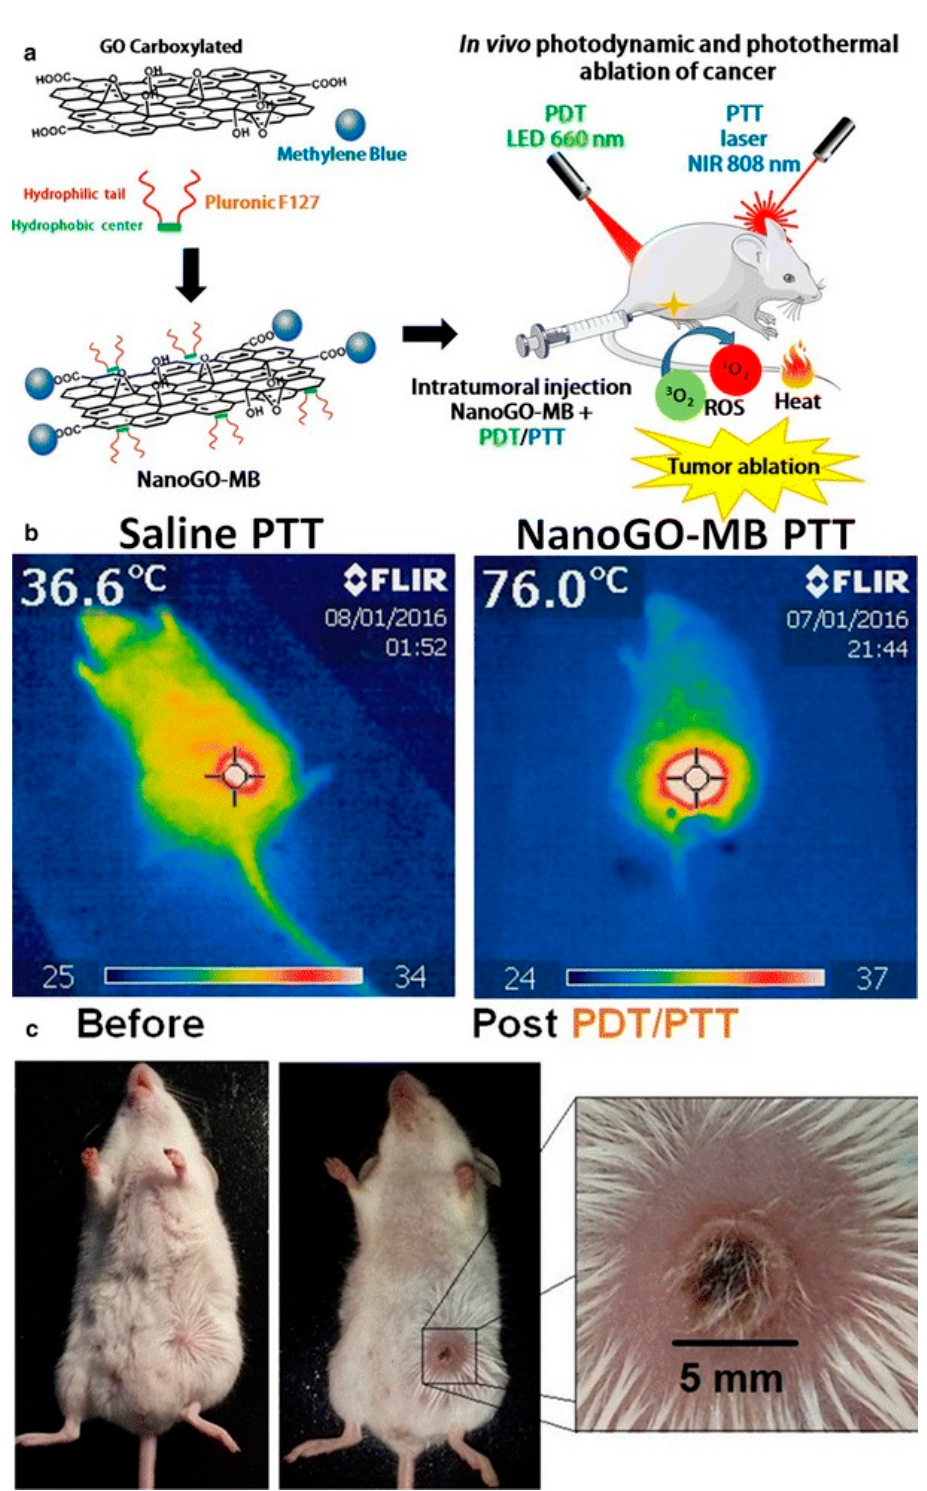
Figure 5. Combined PDT/PTT treatments with nanoGO-MB. ( a ) Schematic representation of nanoGO-MB phototherapies. On both therapies, only the tumor region was exposed to the irradiation, thus the other areas were protected from the light. ( b ) Real-time thermal camera imaging during PTT treatment. A temperature increase of approximately 40 °C was observed only at the tumor region. In this study, the 4T1-Luc tumor-bearing mice were used. ( c ) Tumor site after combined PDT/PTT therapies. The healing tissue measured 5 mm. Reproduced from [55].